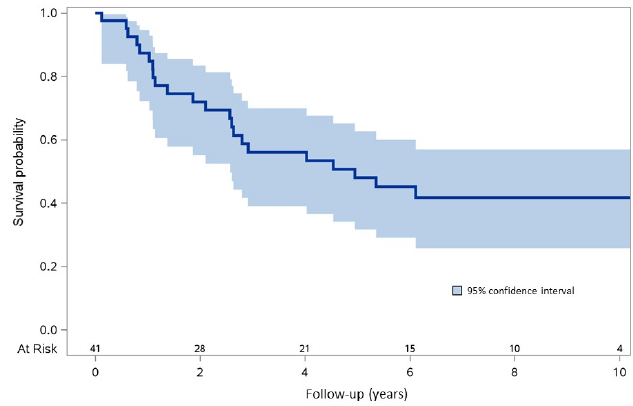
Figure 2. Overall survival in HCC/PLWH who received IT.